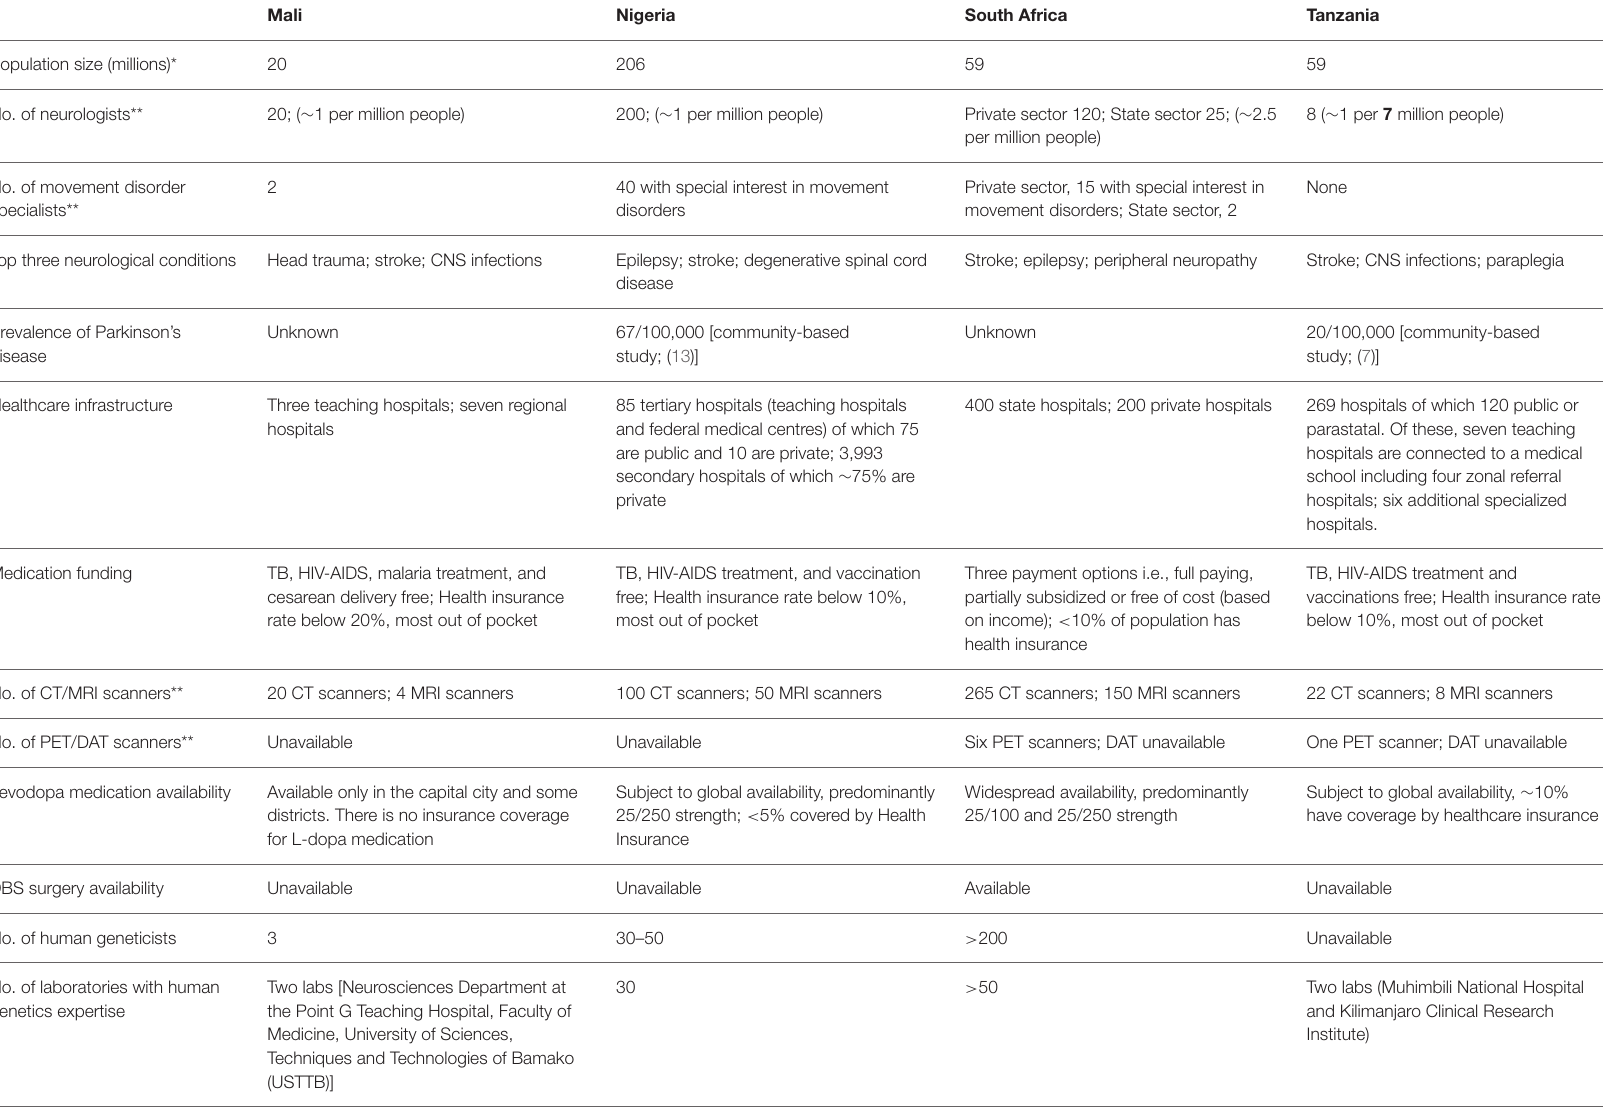
TABLE 1 | Summary of healthcare and clinical resources available for the clinical management of Parkinson’s disease in four sub-Saharan African